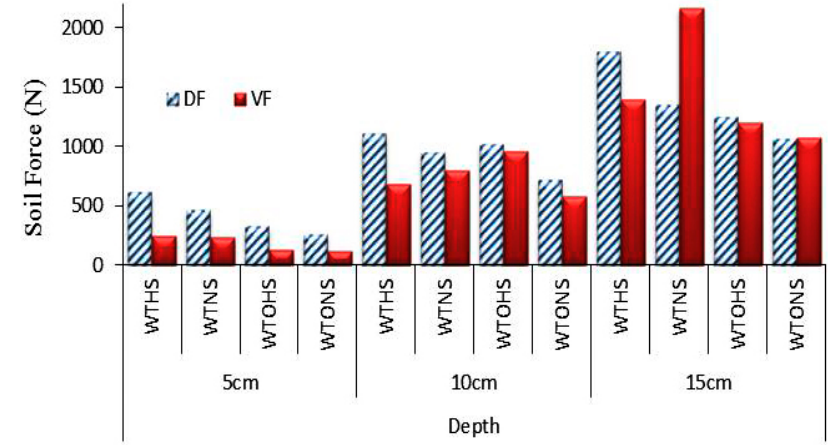
Figure 4. Soil force at 24% water content and tool parameters with different straw conditions and different depths. WTNS: plow with a trash-board in stubble condition; WTONS: plow without a trash-board in stubble condition; WTHS: plow with a trash-board in dense straw cover; WTOHS: plow without a trash-board in dense straw cover (WTOHS).